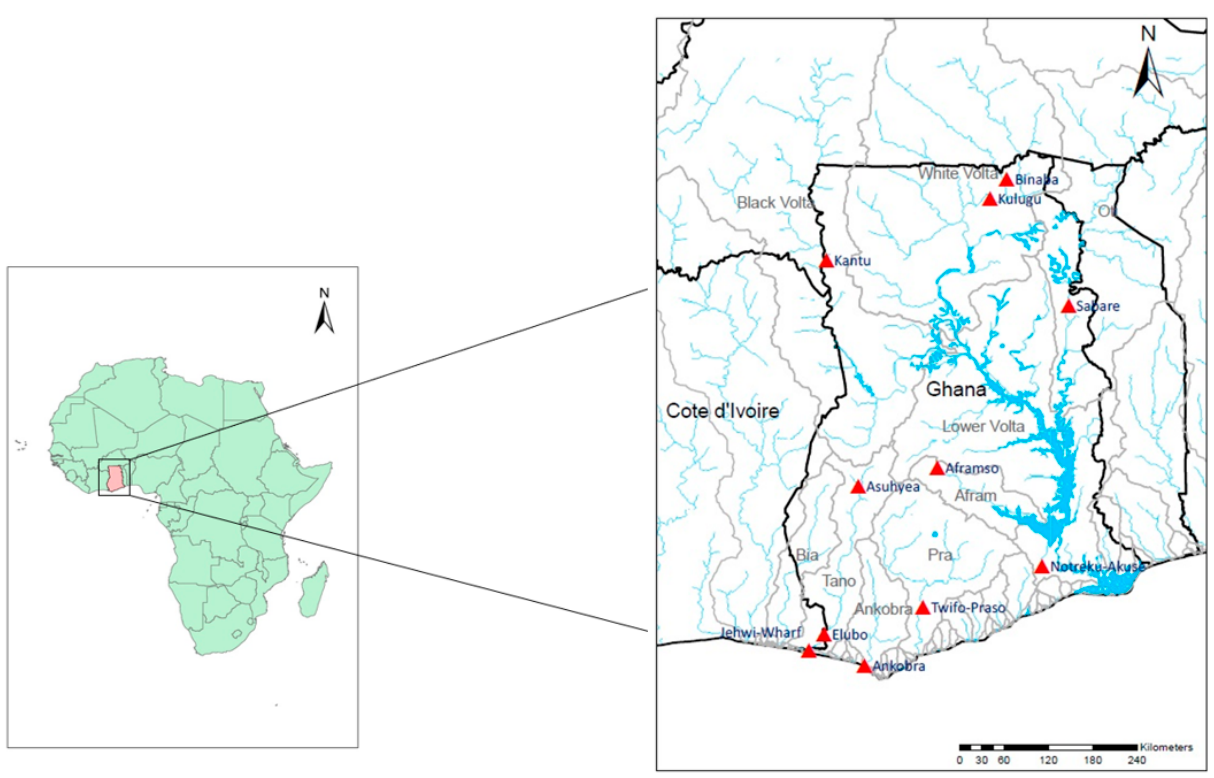
Figure 1. Sampling locations for wild Oreochromis niloticus collected in Ghana at 11 sites from eight rivers and one coastal lagoon from December 2014 to July 2017. Sampling sites are indicated with red triangles. Table 1. Summary of genetic variation among eight microsatellite DNA loci examined in wild tilapia populations from 11 sites (nine river basins) collected in Ghana from December 2014 to July 2017. N = number of individuals genotyped per locus, H o = observed heterozygosity, H e = expected heterozygosity, A = mean number of observed alleles per locus, A r = allelic richness, PrA = number of private alleles, Range = base-pair differences between the shortest and longest microsatellite alleles observed per locus, M -ratio = approximate ratio of A and Range, and F IS = inbreeding coefficient.